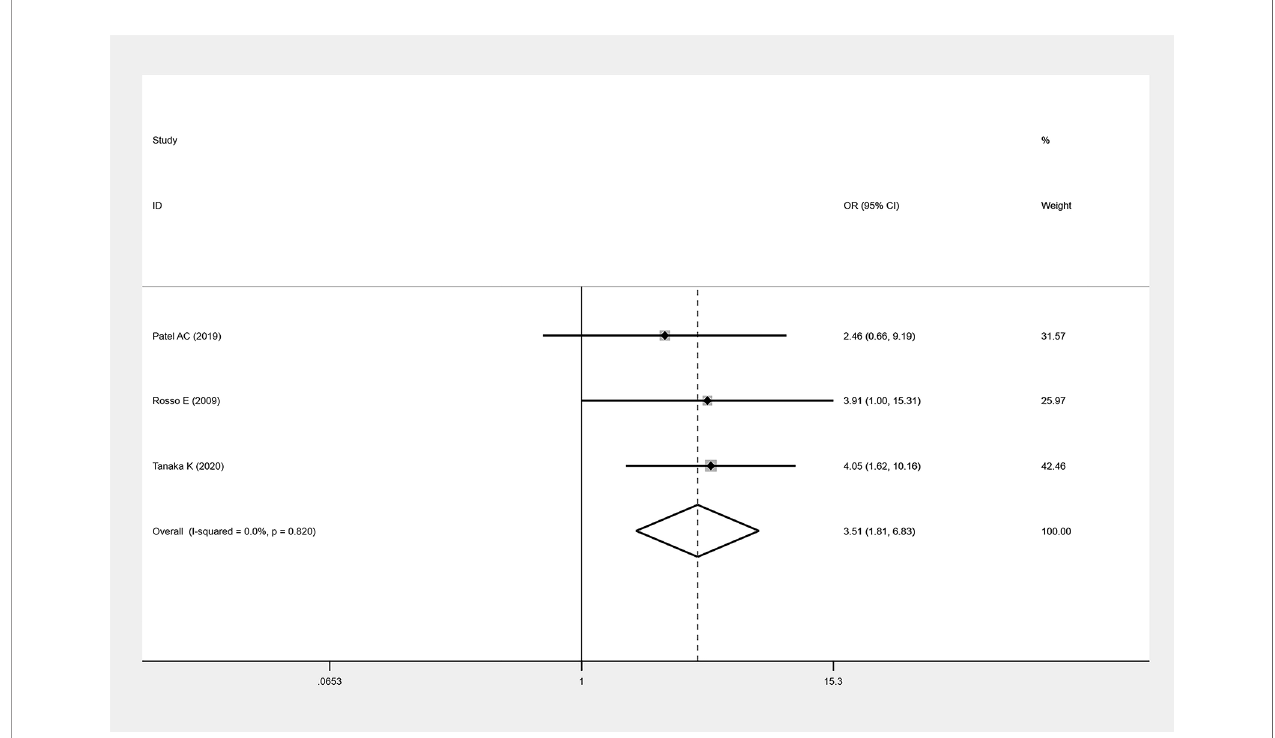
FIGURE 3 | Forest plots of BMI on POFP.